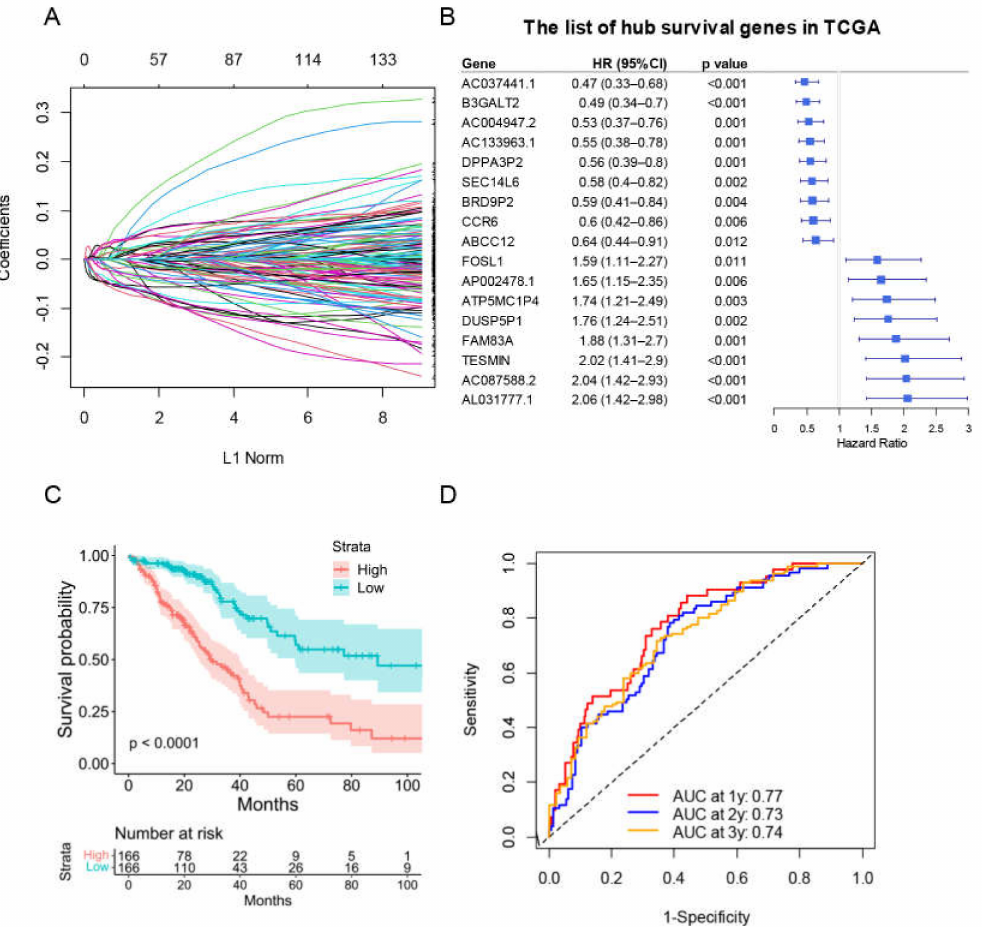
Figure 9. The construction of risk score model for the OS of LUAD patients in training group. ( A ) Selection of the mitophagy-related hub survival genes by LASSO Cox analysis. ( B ) The forest plot containing the selected hub survival genes in TCGA database. ( C ) The KM plot of the high or low risk score LUAD patients in TCGA. ( D ) The AUC plots of risk score to predict the 1-, 2-, and 3-year OS of LUAD in TCGA training